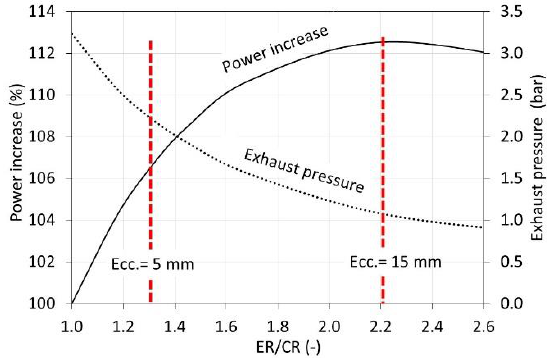
Fig. 12. Power increase and exhaust gas pressure at the end of the expan- sion stroke As analyzed plots in Fig. 12, the remarkably low ex- haust pressure of approximately 1 bar is observed at the end of the expansion stroke when the exhaust valve gets open for ER/CR of 2.2. This is the additional benefit from apply- ing the over-expanded cycle. The exhaust pressure close to ambient pressure at the exhaust valve opening does not generate a pressure wave in the exhaust manifold, and